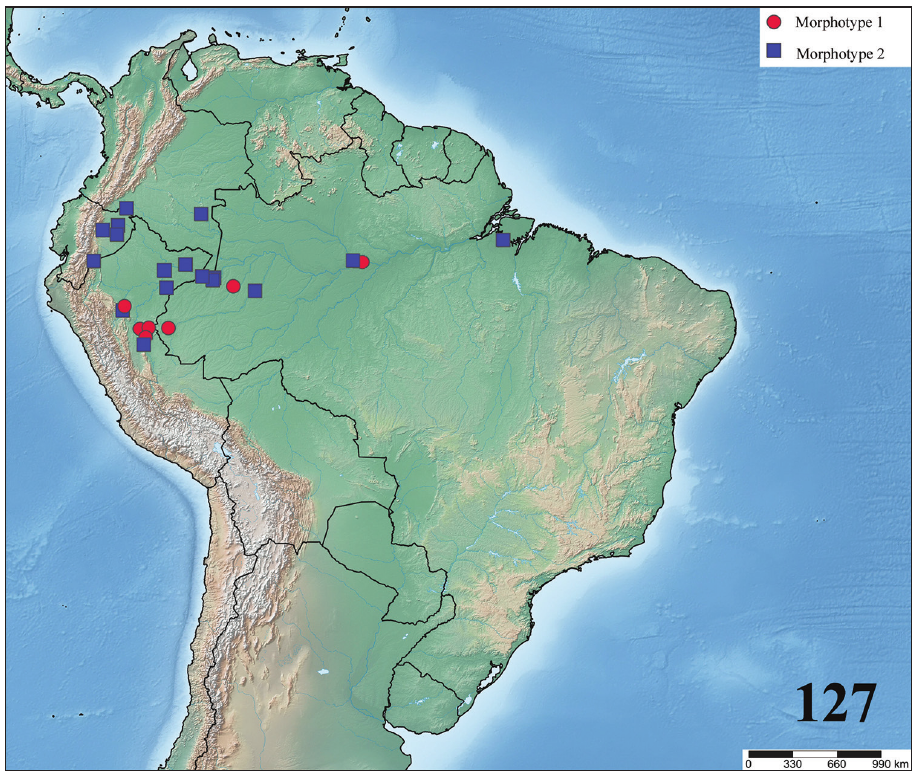
Figure 127. Map showing records of Avicularia juruensis Mello-Leitão, 1923